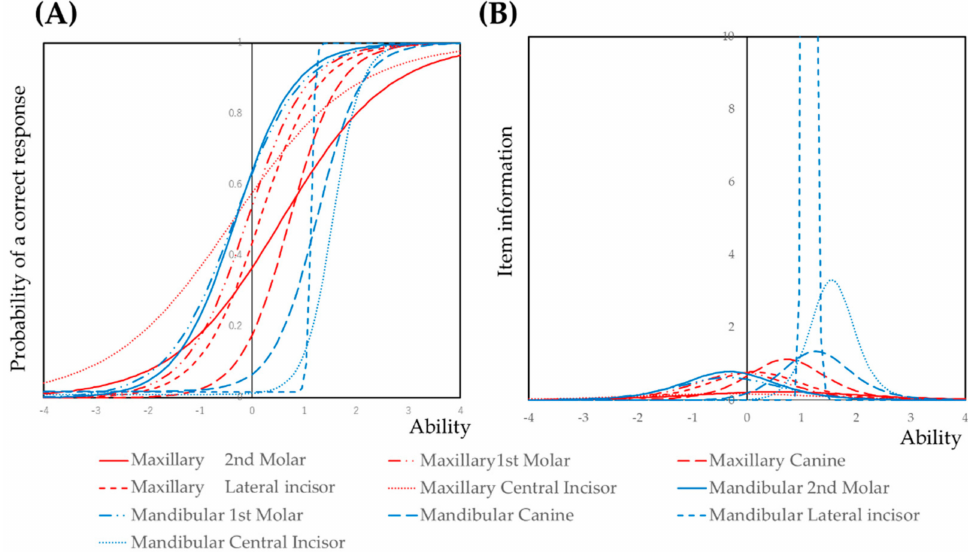
Figure 1. Item response curves and item information curves for the prevalence of dental caries. ( A ) Item response curve; ( B ) item information curve. In item response theory (IRT) analysis, the discriminatory power of an item is presented by the steepness of the curve at its inflection point and height of the item information curve. A steep curve and high item information indicate a distinction between respondents with low ability levels versus those with high ability levels. The item response curve and item information curve located in the forward direction indicated that subjects with high ability have a probability of a correct response. The item response curve and item information curve located in the backward direction indicate that even subjects with low ability can respond correctly. Susceptibility for dental caries was di ff erent between tooth types. The maxillary central incisor was found to often have dental caries. By contrast, the item response curve of the mandibular lateral incisor was steep and located in the forward direction, and the item information curve was high. It indicated that the mandibular lateral incisor often did not have dental caries. If dental caries was detected in the mandibular lateral incisor, most of the teeth were found to have dental caries in the primary